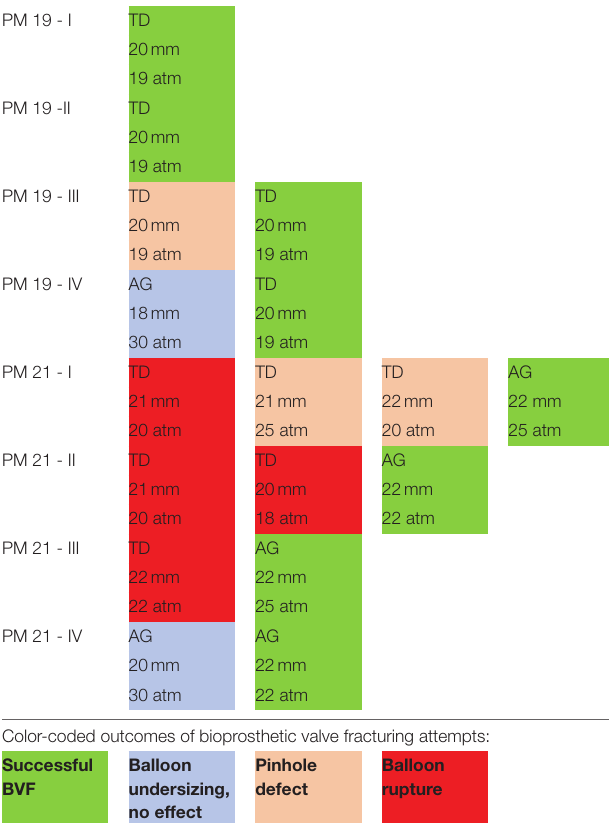
TABLE 2 | Overview of perviously reported data and data acquired within the present study on required pressure rates to achieve in-vitro BVF using the atlas